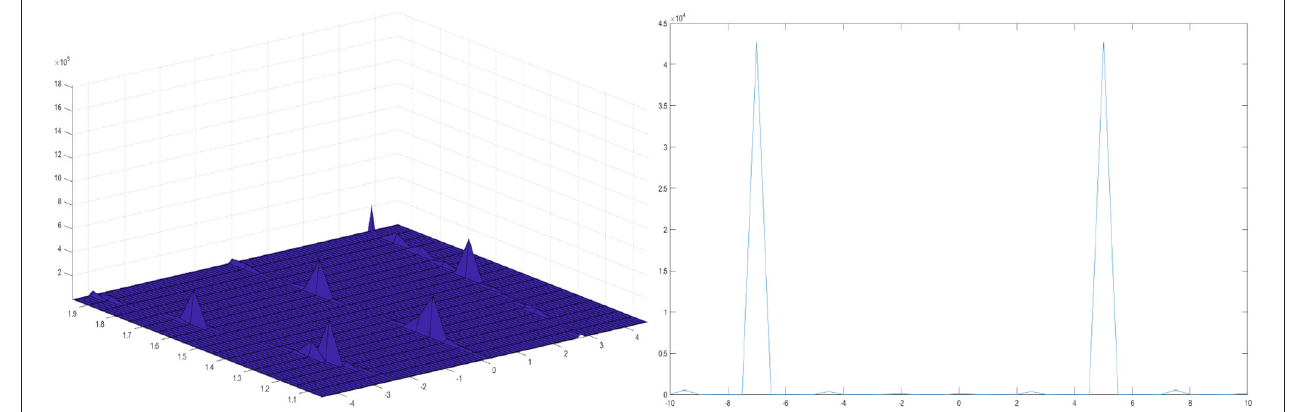
FIGURE 1 | Periodic wave solution of the loaded KdV equation for k